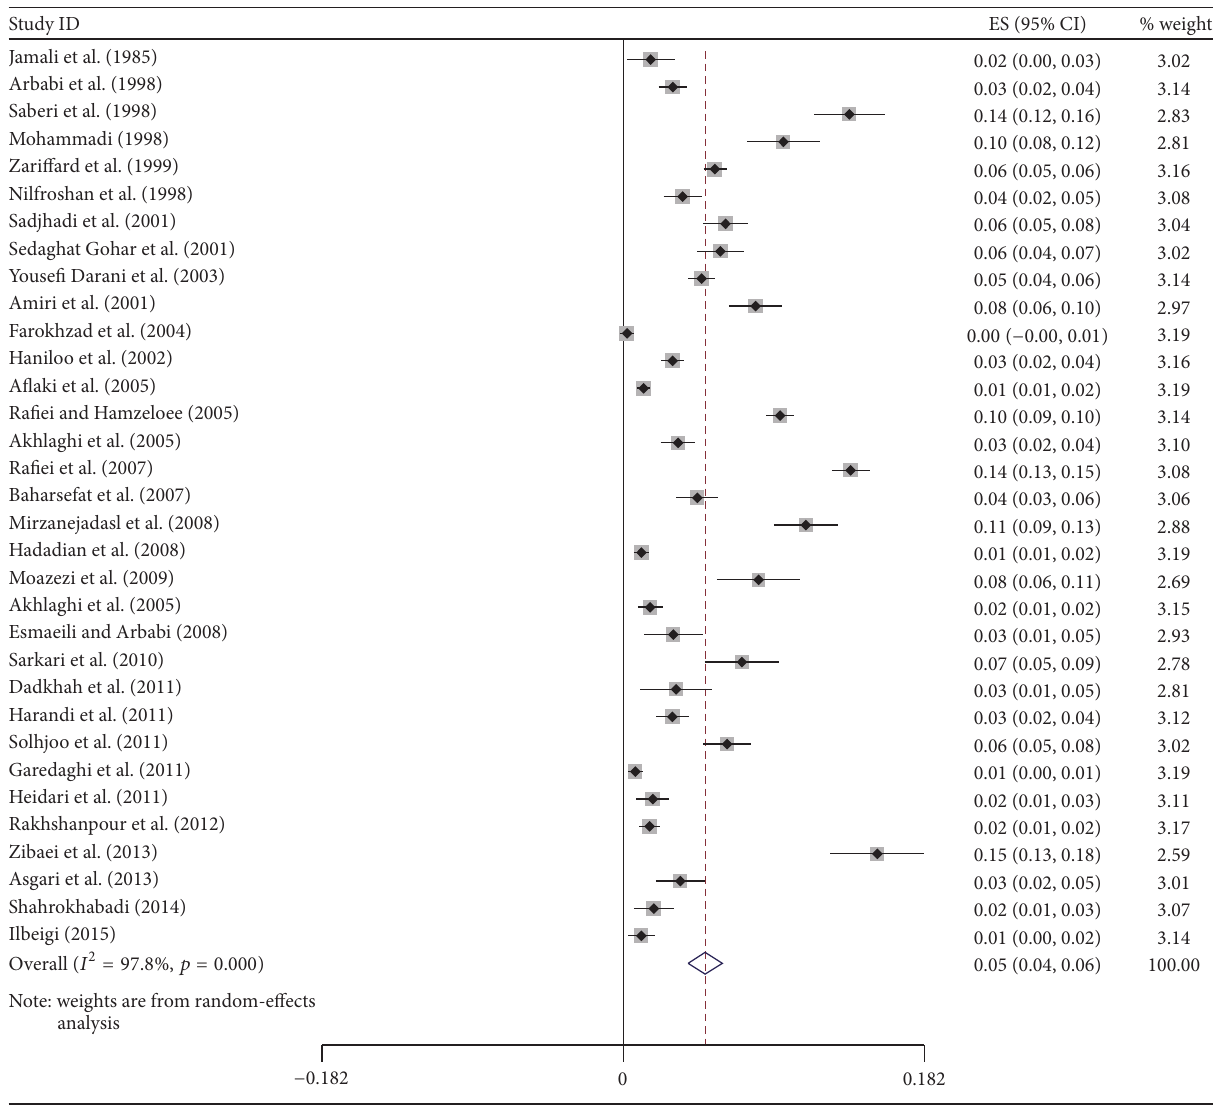
Figure 3: Forest plot of meta-analysis results for prevalence of CE. The middle point of each line indicates the prevalence rate and the length of line indicates 95% confidence interval of each study. Rhombus shape indicates 95% confidence interval for all studies.